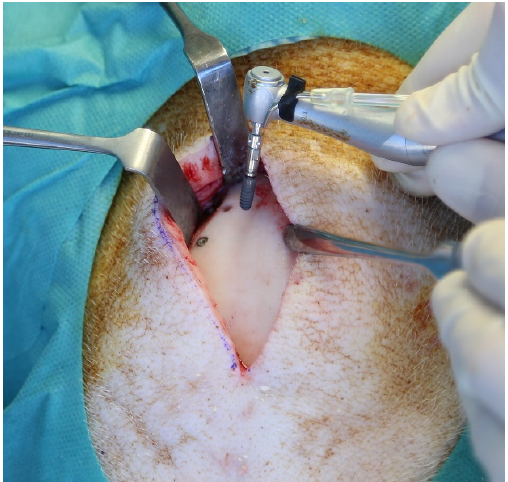
Figure 1. Placement of the implants into the frontal bone.